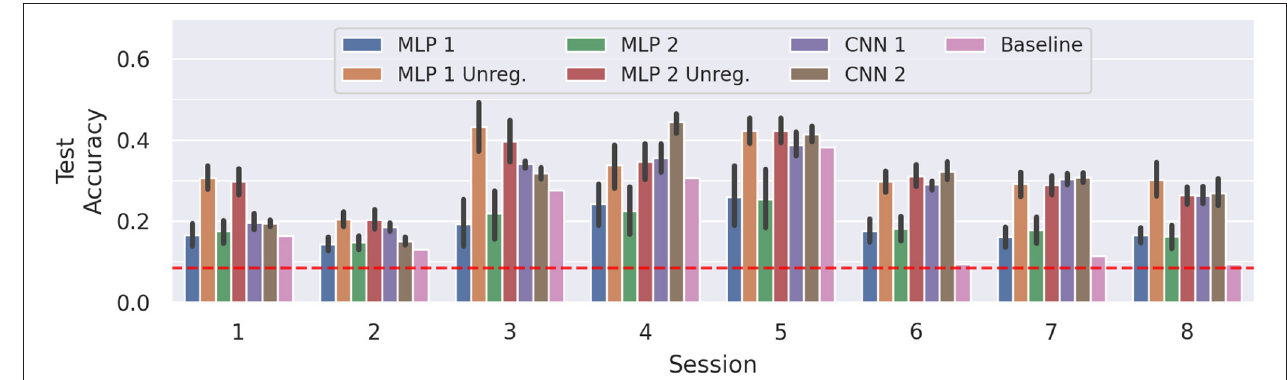
FIGURE 6 | Average test accuracies of cross-session recognition on subject E . The vertical lines mark the 95% confidence interval and the red dotted line depicts chance level classification accuracy. The displayed data is drawn from 10 trials of evaluation performed in a leave-one-session-out cross-validation fashion, summing up to 80 training runs per model. The session number corresponding to each block denotes the session left out for testing. Note that for the baseline only one result per session is available, thus no confidence intervals can be computed.